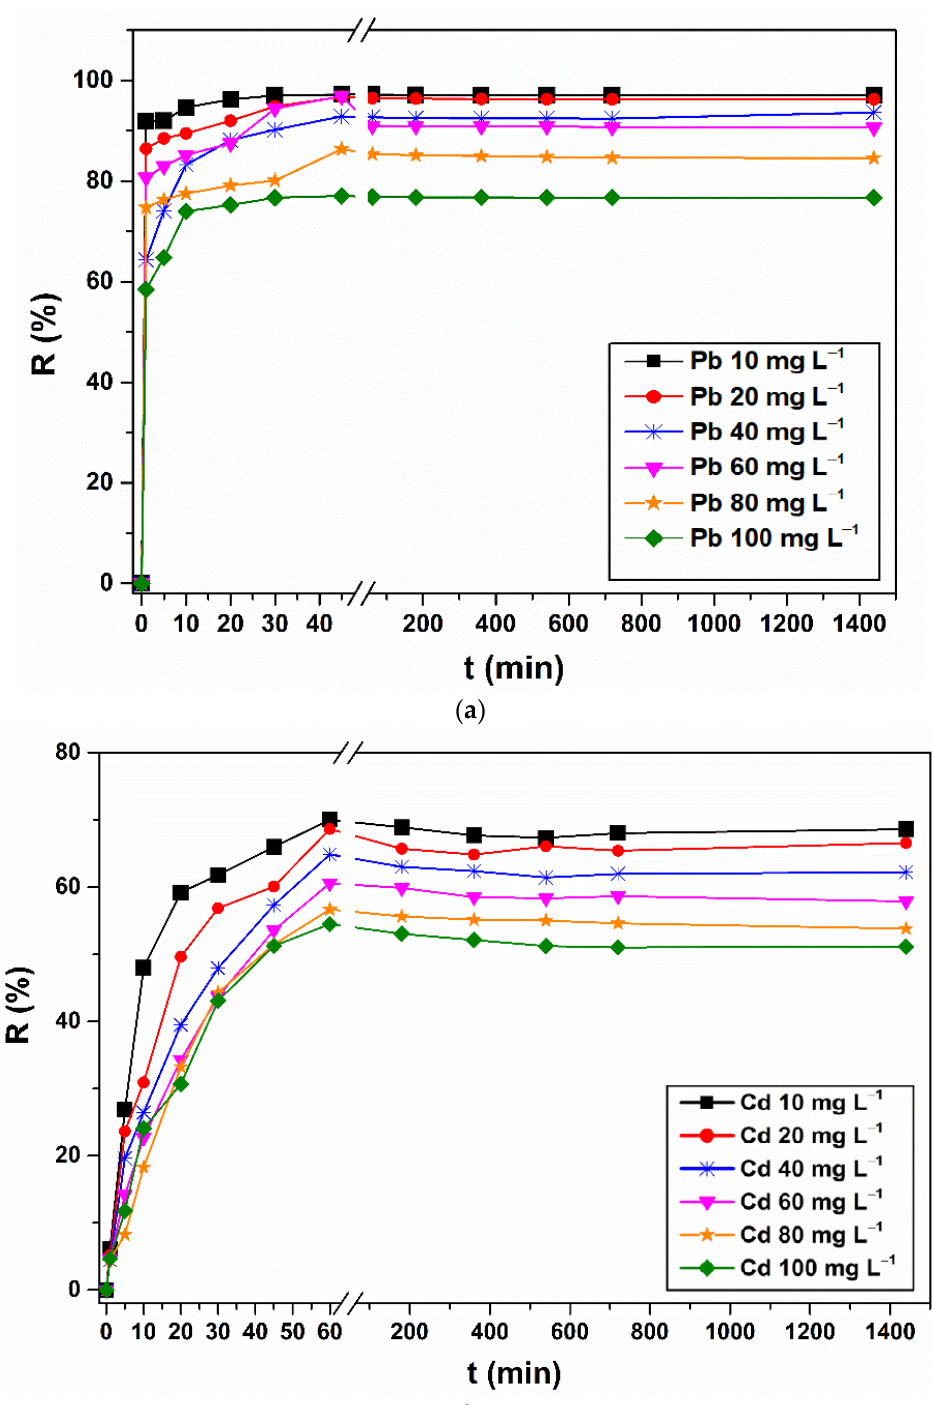
Figure 8. The effect of contact time on ( a ) Pb and ( b ) Cd removal efficiencies of CHIT-PAAA .